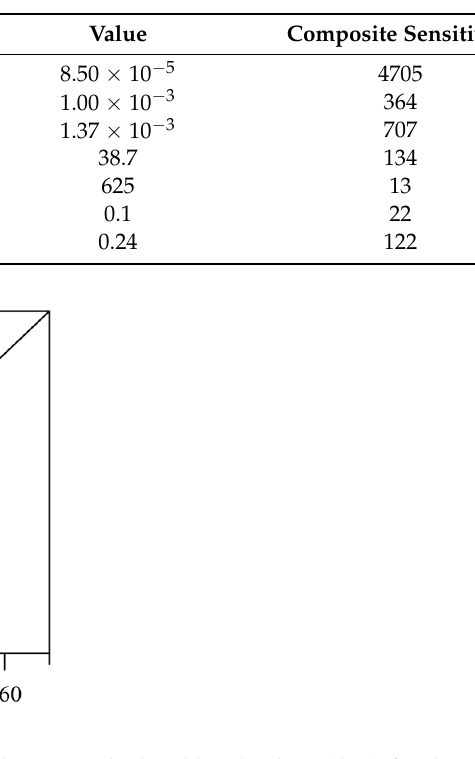
Figure 9. Scatter diagram of the observed versus calculated head values (dots) for the simulated aquifers system. aquifers Table 2. Calibrated parameters values and their composite sensitivity via PEST.